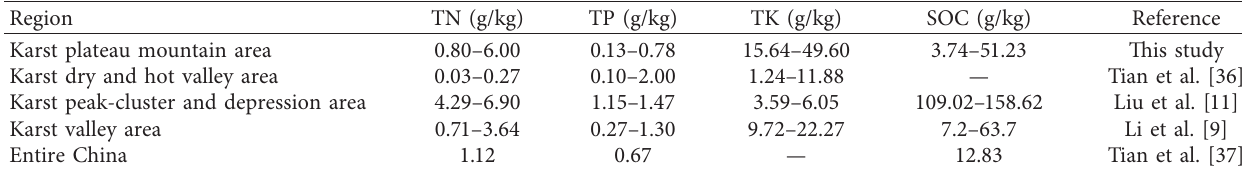
Table 5: Comparison of soil nutrient contents with other